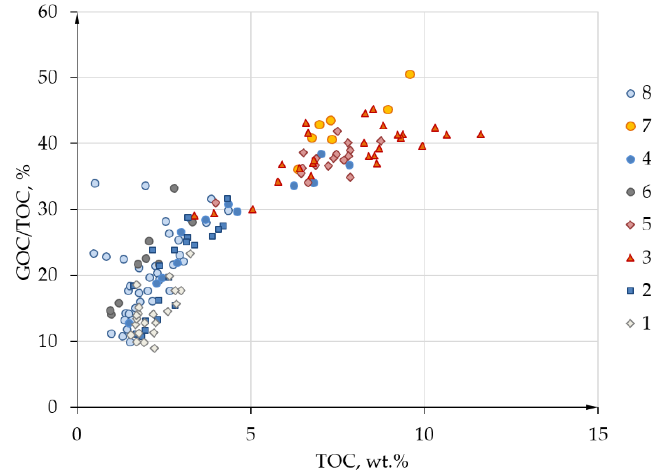
Figure 7. Cross-plot of TOC and generative organic carbon (GOC/TOC, %) for the samples from the studied section. Red and orange markers are used for the members #3, #5, and #7 (average TOC > 5 wt.%), grey and blue are for the members #1, #2, #4, # 6, and #8 (average TOC < 5 wt.%).